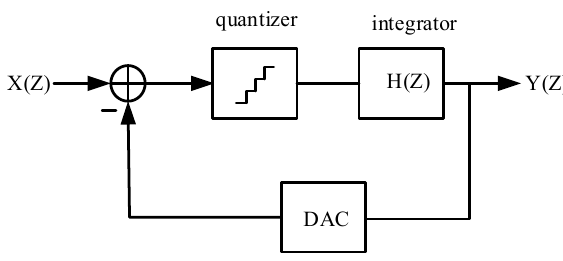
Figure 1. Sigma-delta analogue-to-digital converter (ADC) system block diagram.